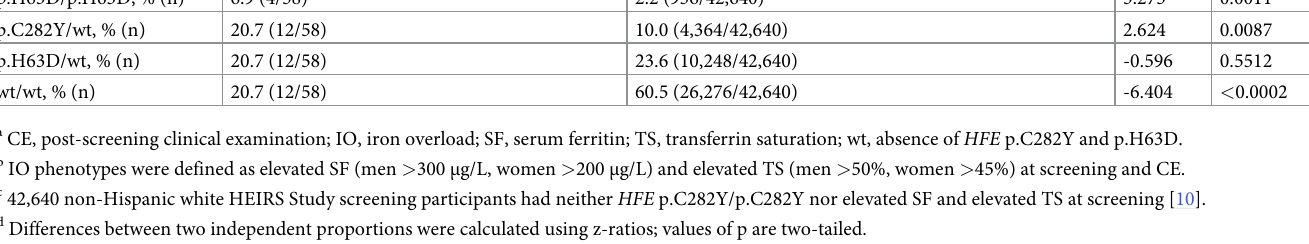
Table 2. HFE genotypes and iron overload phenotypes in non-Hispanic white participants without HFE p.C282Y/p.C282Y a .